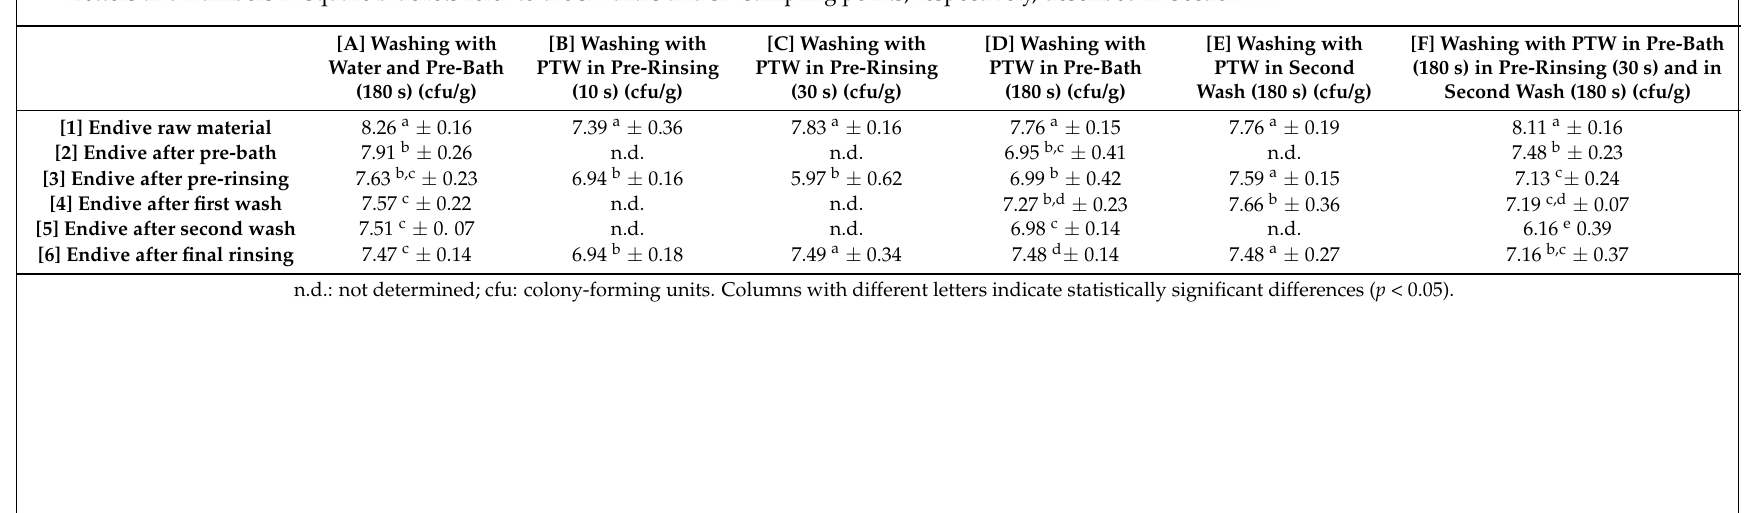
Table 2. Total viable count on stored (2 ◦ C, seven days) endive lettuce after washing with or without the addition of plasma-treated water at different processing steps. Letters and numbers in square brackets refer to the six trials and six sampling points, respectively, described in Section 2.2.